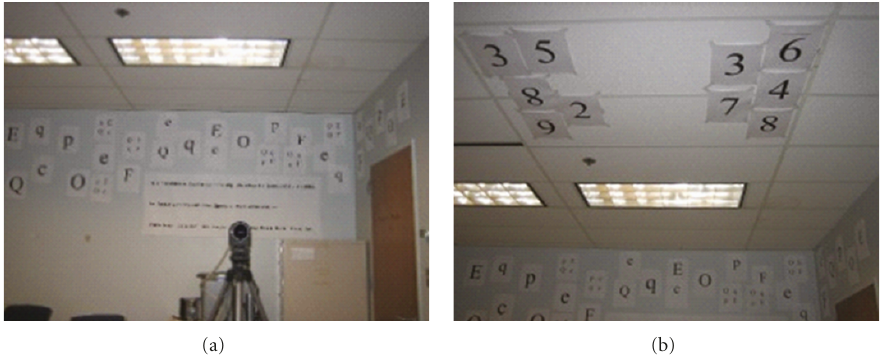
Figure 10: Remote Iris Image Acquisition Station Set Up.